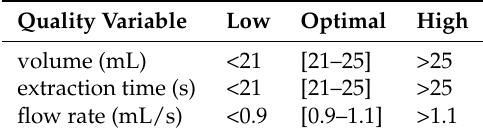
Table 4. Data-driven quality thresholds.